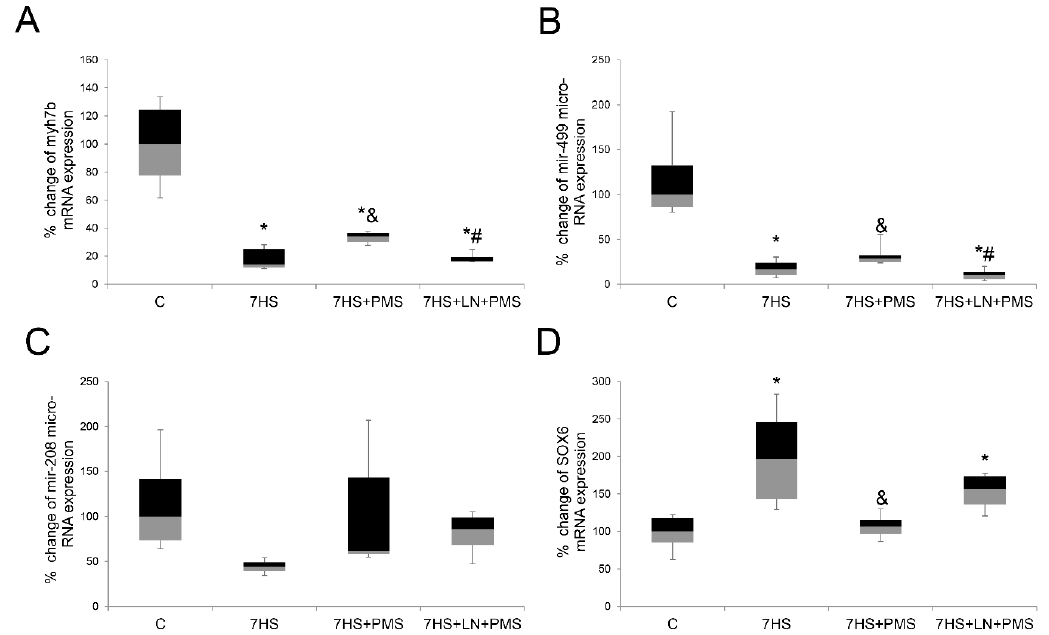
Figure 4. Expression levels of myh7b mRNA ( A ), mir-499 micro-RNA ( B ), mir-208 micro-RNA ( C ) and SOX6 mRNA ( D ) in rat soleus muscle in control group (C), 7-day hindlimb-suspended group (7HS), 7-day hindlimb suspended group with plantar mechanical stimulation (7HS + PMS), 7-day hindlimb suspended group with plantar mechanical stimulation+ L-NAME introduction (7HS + LN + PMS). Data are shown as % of the control group. *—significant difference from the control group. &—significant difference from 7HS group. #—significant difference from 7HS + PMS group ( p < 0.05). Box plots show 25–75 percentiles and median values and the whiskers represent the minimum and the maximum; n = 8/group.